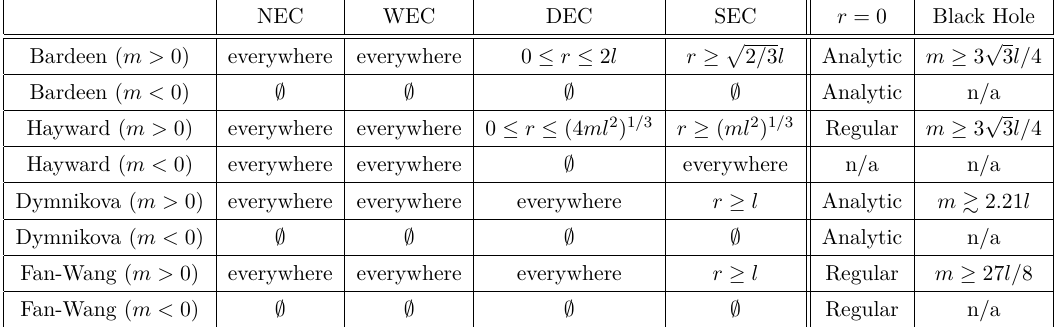
Table 4 . The domains of r where the standard energy conditions are respected in the Bardeen, Hayward, Dymnikova, and Fan-Wang spacetimes with l > 0